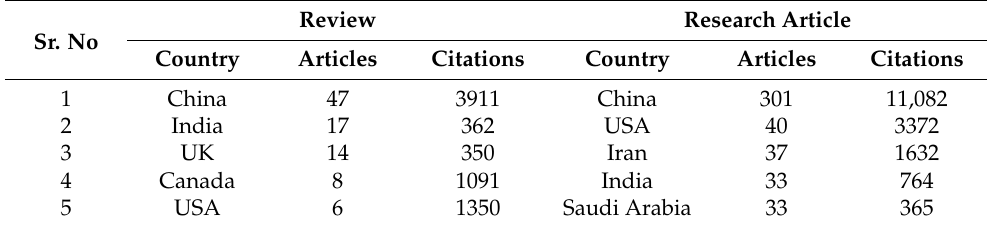
Table 2. Top five countries with more publications.